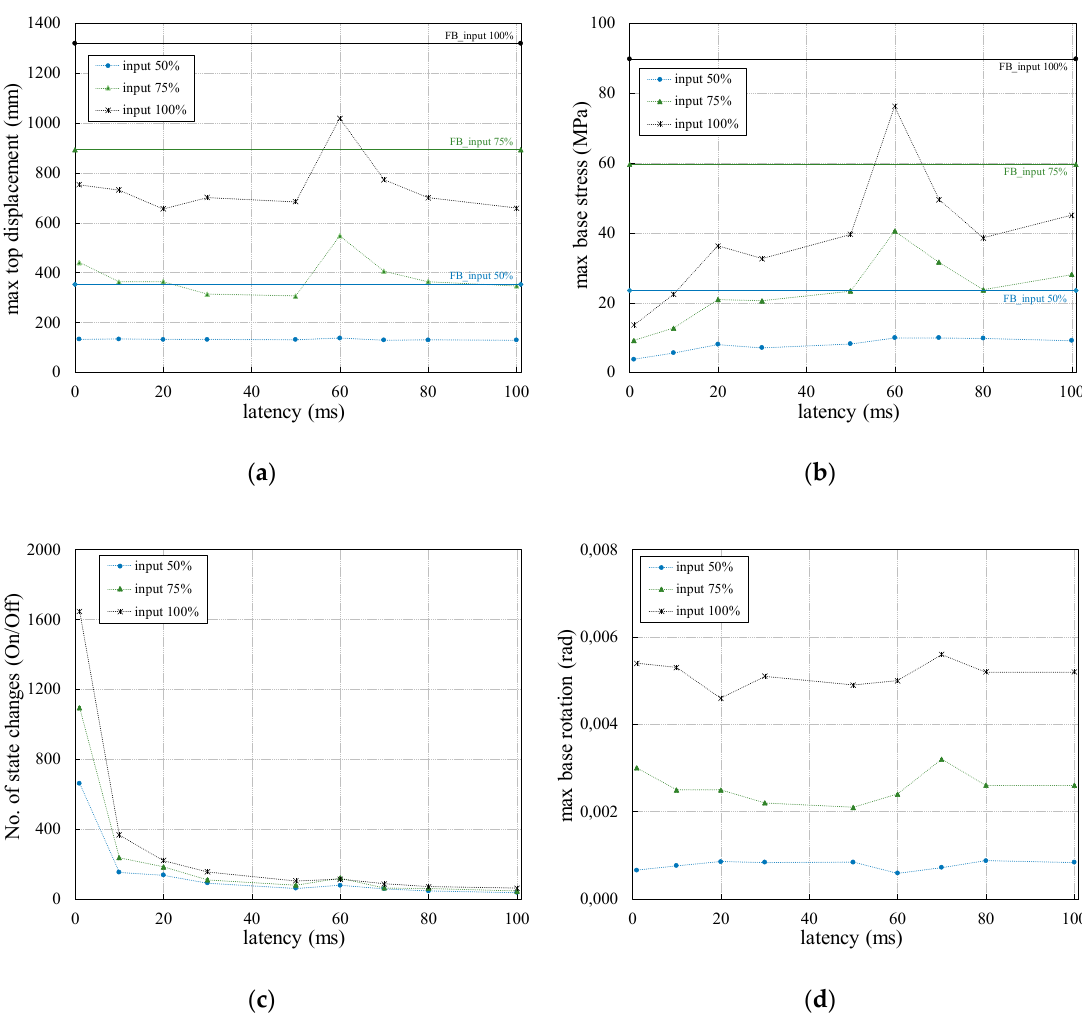
Figure 9. Response of the wind turbine for di ff erent latencies of measurements: peak top displacement ( a ), peak base stress ( b ), No. of state changes ( c ), peak base rotation ( d ).